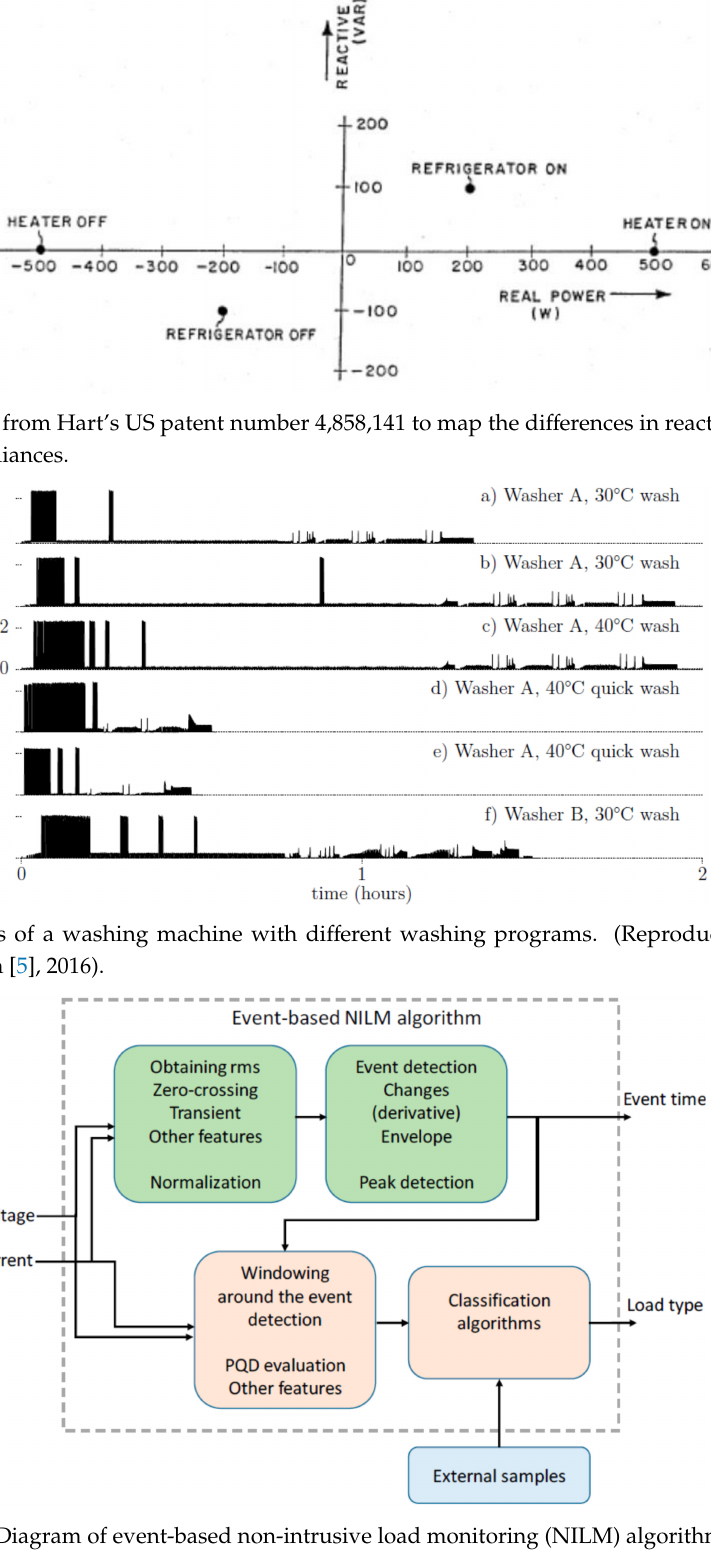
Figure 6. Diagram of event-based non-intrusive load monitoring (NILM) algorithms